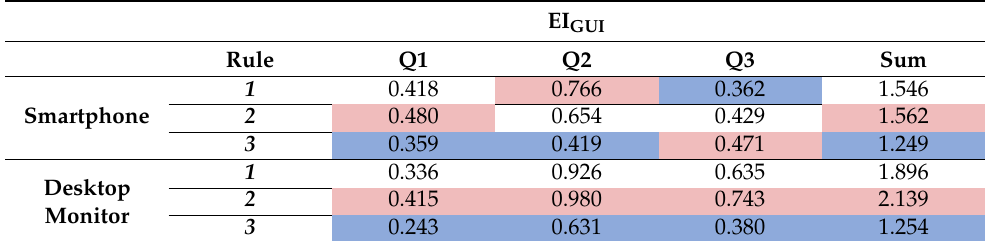
Table 2. GUI effectiveness index (EI GUI ) for individual tasks and variants of the GUI button